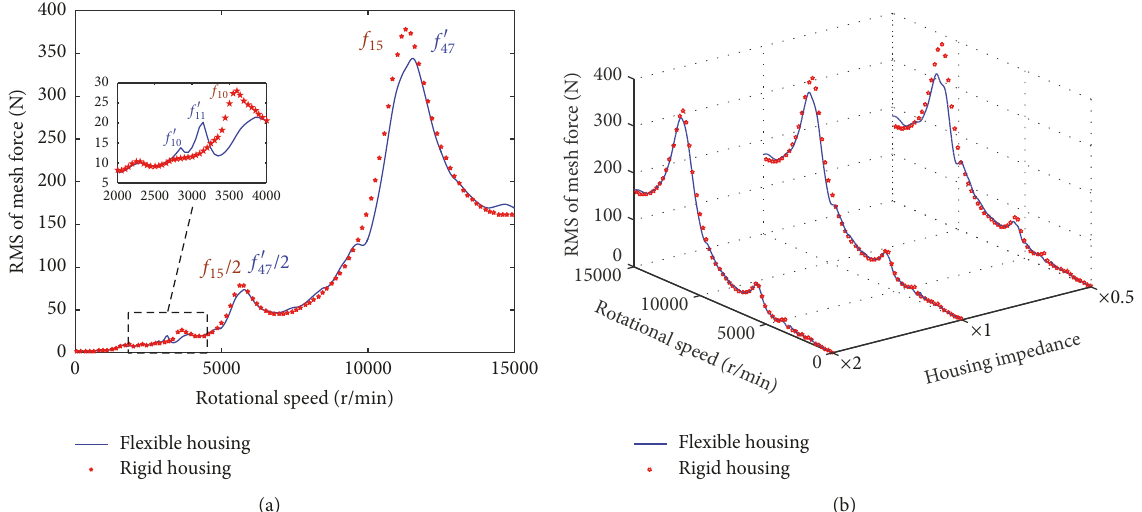
Figure 11: Housing influence on RMS of dynamic mesh force: (a) Original housing impedance; (b) modified housing impedances.